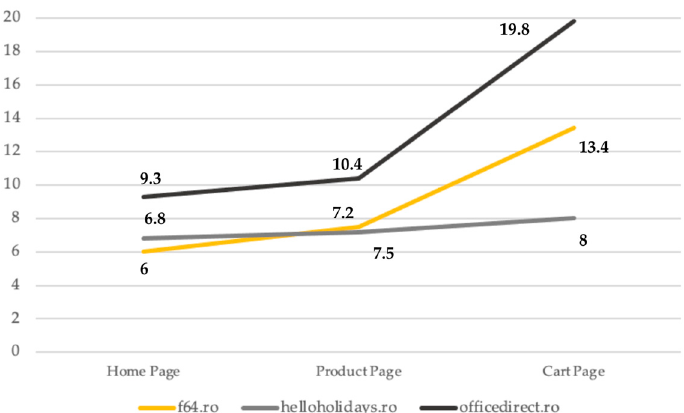
Figure 2. The loading speed for retailers that show an increase in the number of seconds as the user draws near the shopping cart.